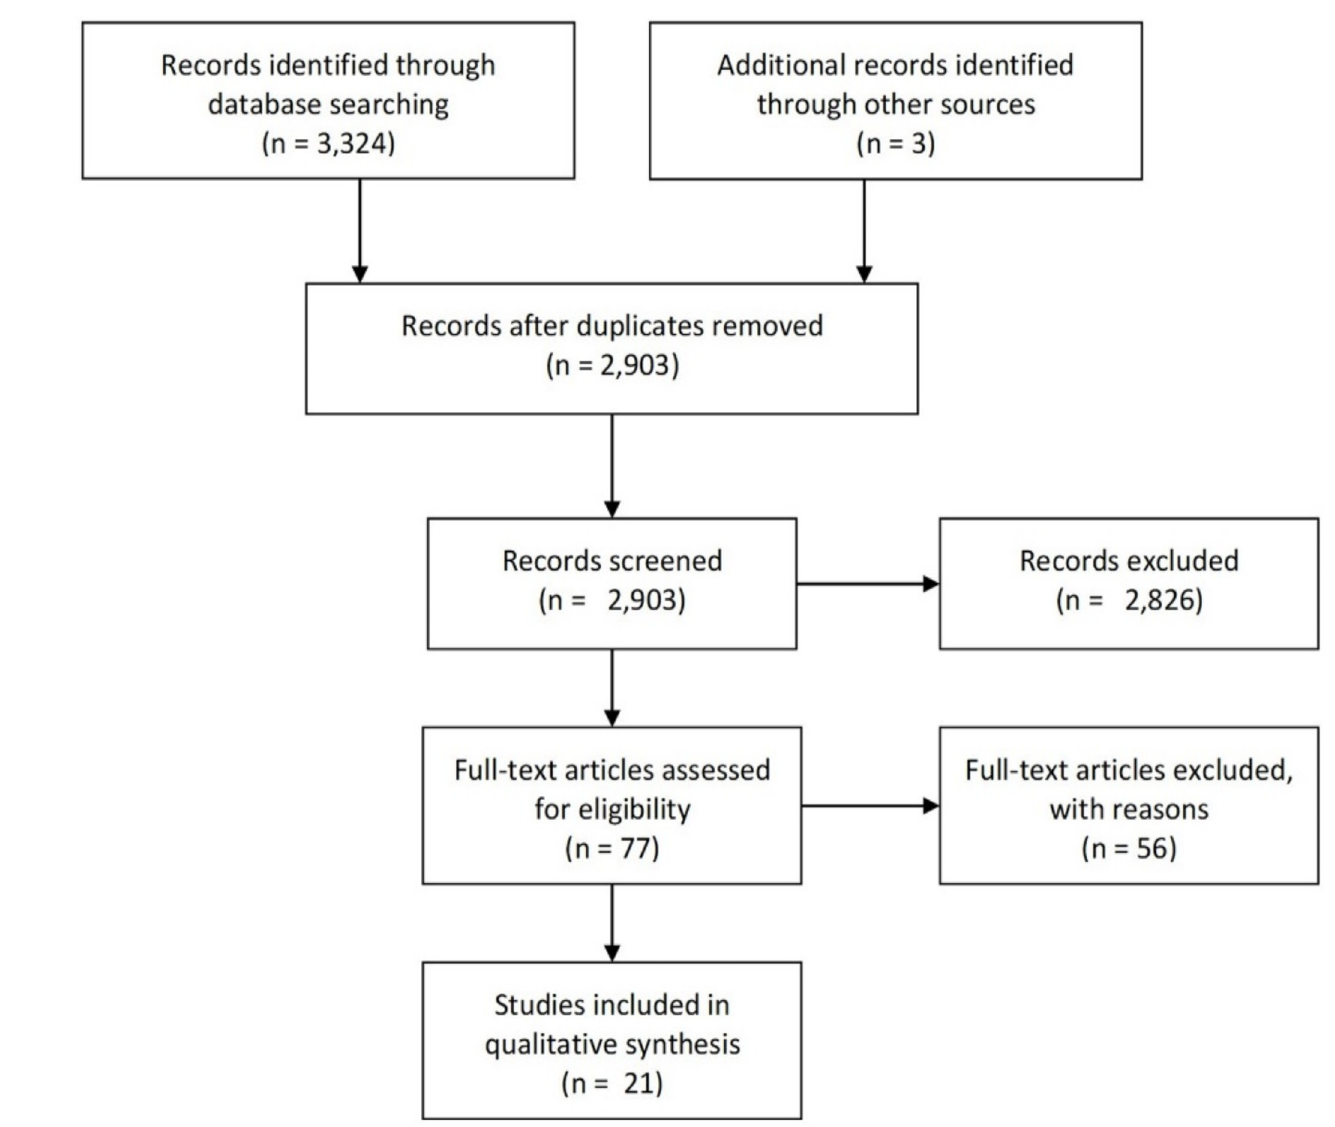
Fig 1. Study flow diagram. Results of systematic review identification, screening, and